Question: What does this figure show? Answer in one sentence.
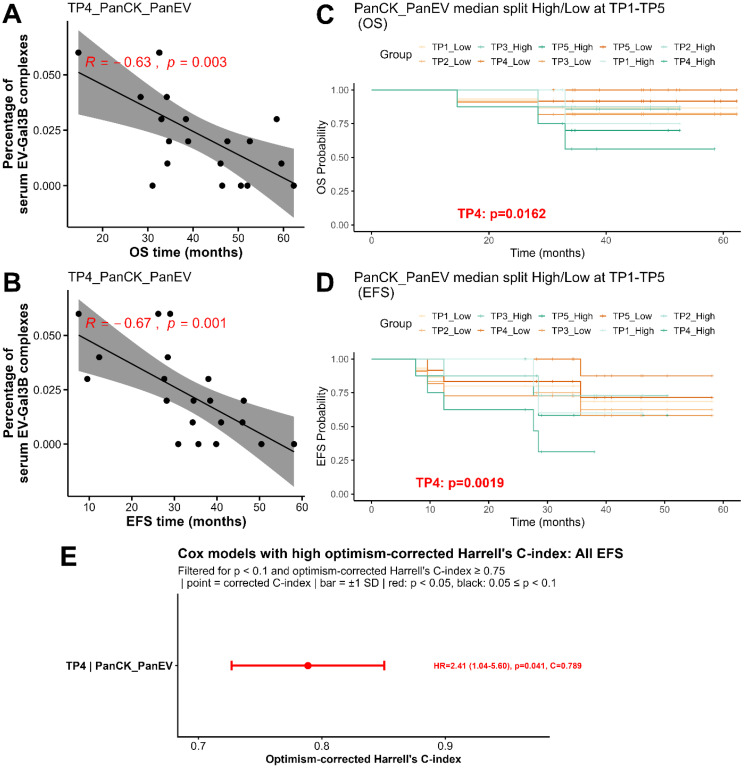
Answer: (A, B) Correlation of PanCK + /PanEV + -EXÖBead complex at TP4 with OS (p = 0.003) and EFS (p = 0.001). (C, D) Kaplan–Meier analysis of OS and EFS stratified by TP4 PanCK + /PanEV + -EXÖBead levels (OS: p = 0.0162; EFS: p = 0.0019). (E) Continuous-variable Cox regression for EFS at TP4 for PanCK + PanEV + EV-EXÖBead complex (HR per 1 SD: 2.41, 95% CI 1.04–5.60, p = 0.041, optimism-corrected C-index = 0.789); points indicate corrected C-index and bars ±1 SD from bootstrap resampling.